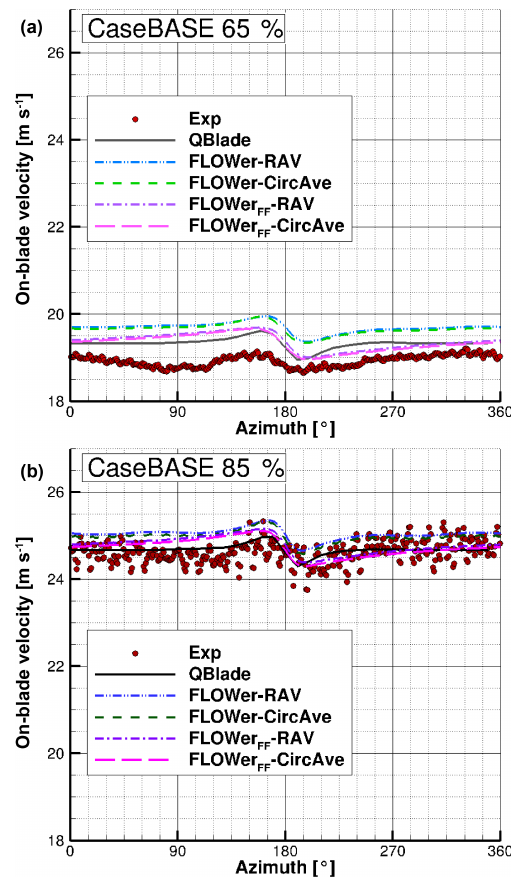
Figure 12. On-blade velocity distribution over the azimuth for CaseBASE for the experiment, QBlade and FLOWer (RAV and CircAve for wind tunnel and far field each) at 65% R (a) and 85% R (b)